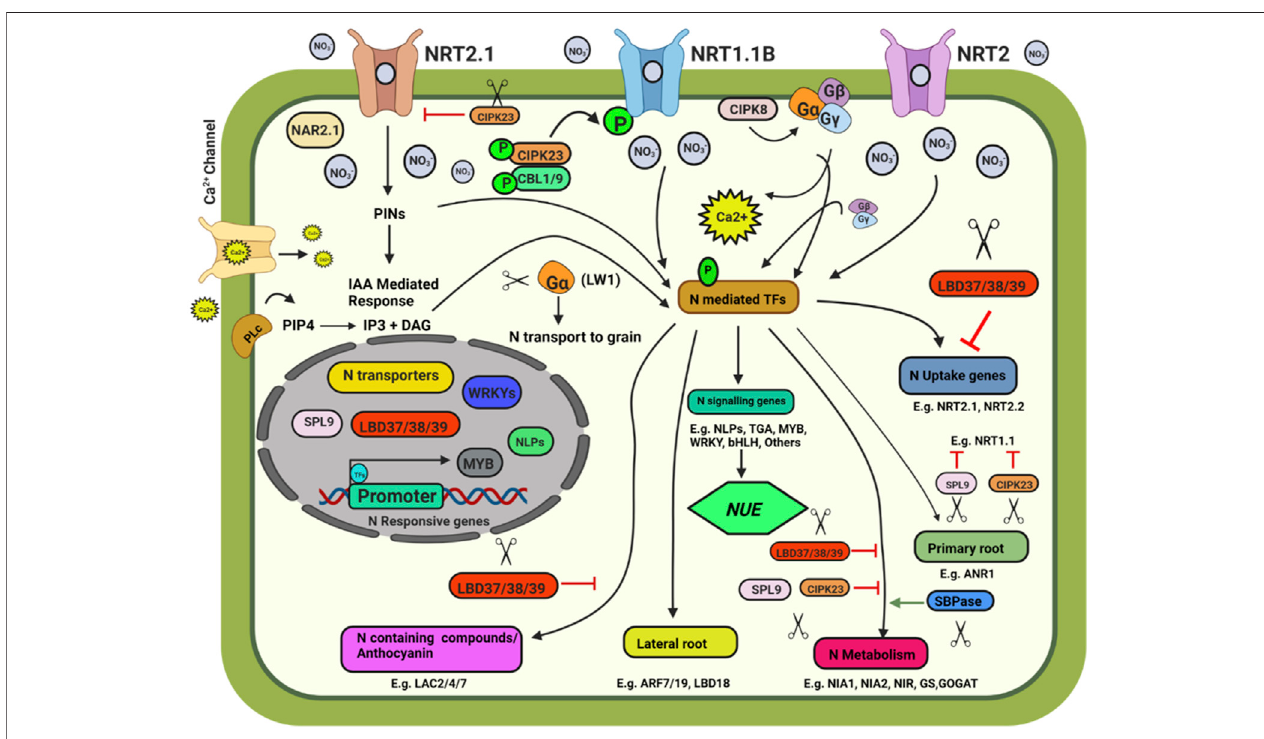
FIGURE 1 | Schematic model depicting plant response to nitrate availability and signaling. Illustration was made with Biorender (https://biorender.com/). The negative regulators for targeted genome editing are indicated with a scissor sign.